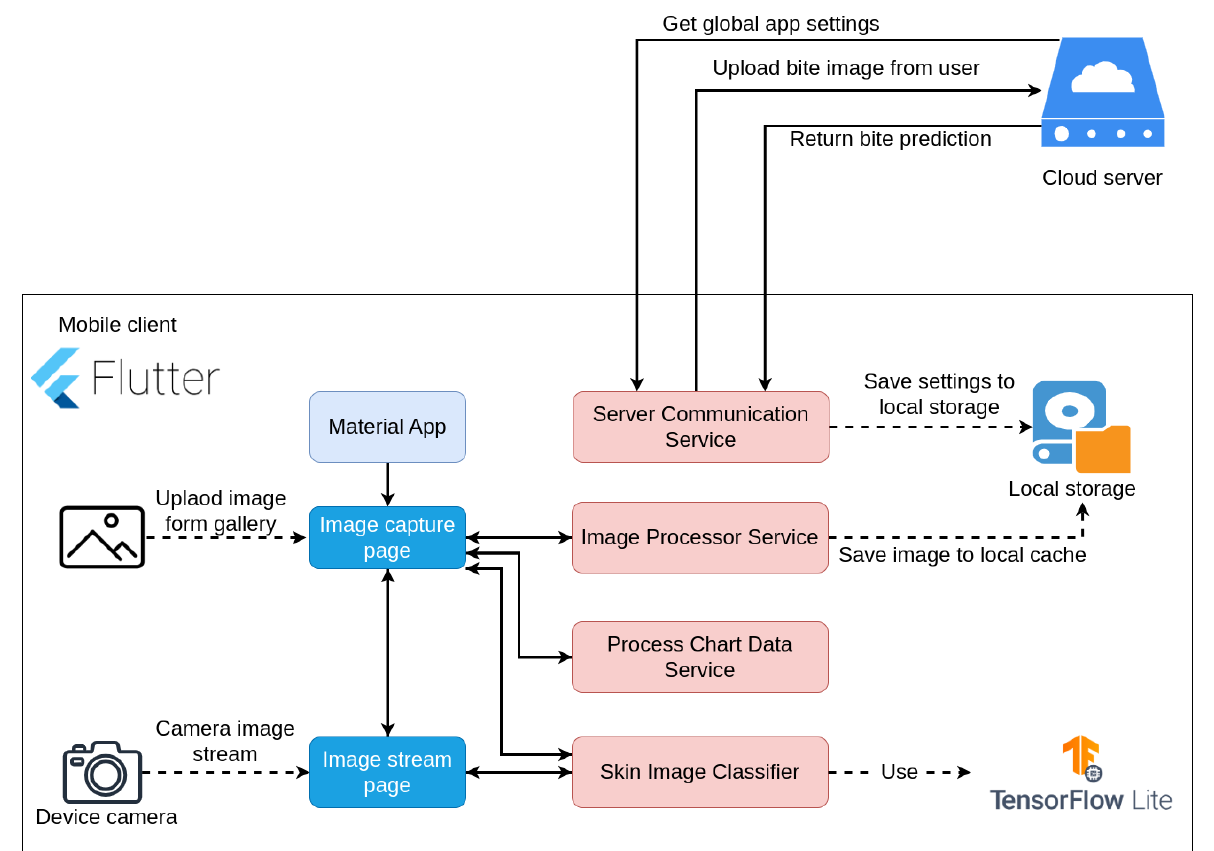
Figure 7. Mobile Application